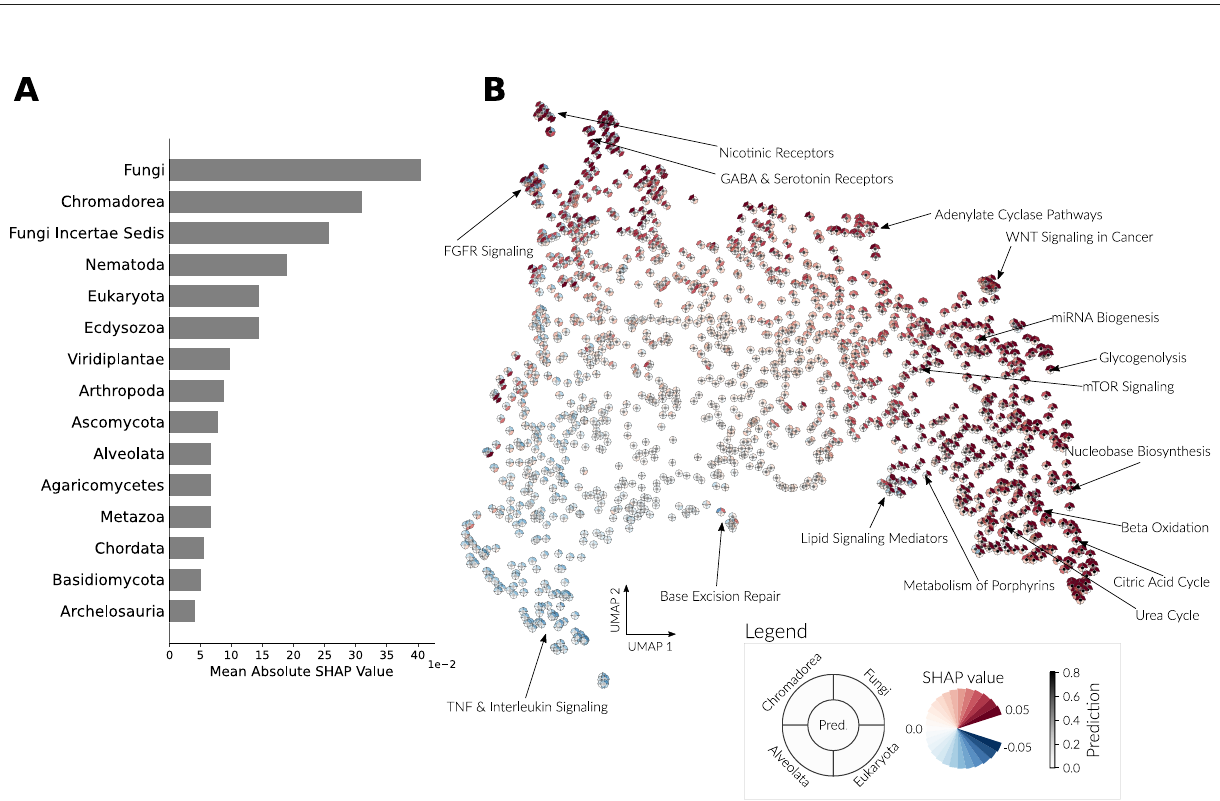
Fig. 5 Evaluating clade importance — citric acid cycle case study. SHAP values were calculated for all gene pairs in the Citric Acid Cycle from KEGG. A speci fi c example is provided here for the gene-pair ACO1 - IDH1 ( A ). Bars represent the SHAP values calculated for the speci fi c clade and colored by the value. SHAP bias term is the probability without knowing the value for any of the clades. Mean SHAP values were calculated across all gene pairs ( B ). Shown are clades with a mean SHAP value above 0.002 and colored by a mean SHAP value. Species go from close to human at 0 degrees to more distant counter clockwise. Clade abbreviations are found in Supplementary Material. All pairwise interactions are shown in a network for Fungi and Chromadorea, the top two most important clades by SHAP values ( C , D , respectively). Edges are colored similar to clades in A. The normalized bitscore matrix for Fungal species for all genes in the pathway highlight their loss at the Microsporidia clade ( E ).